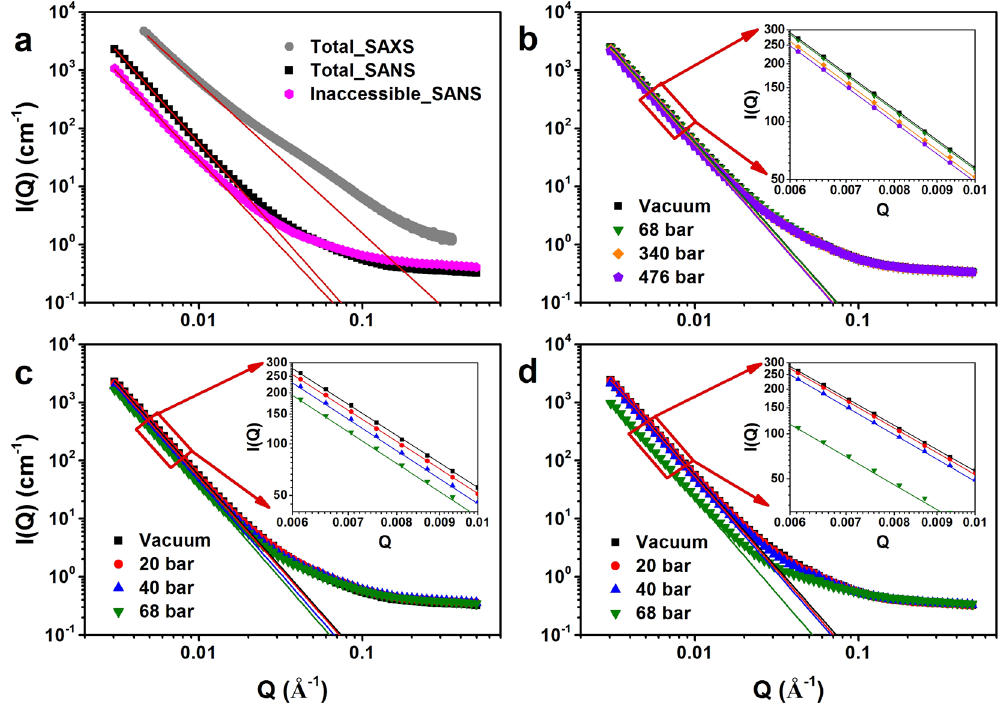
Figure 1. Typical scattering intensities (San Juan coal). ( a ) Scattering intensities of total pores detected by SAXS and SANS, scattering intensities of inaccessible pores detected by SANS; ( b ) scattering intensities during Ar penetration; ( c ) scattering intensities during CD 4 penetration; ( d ) scattering intensities during CO 2 penetration. (Note: The solid lines are modeled power law scattering intensities for fractal dimension determination.).